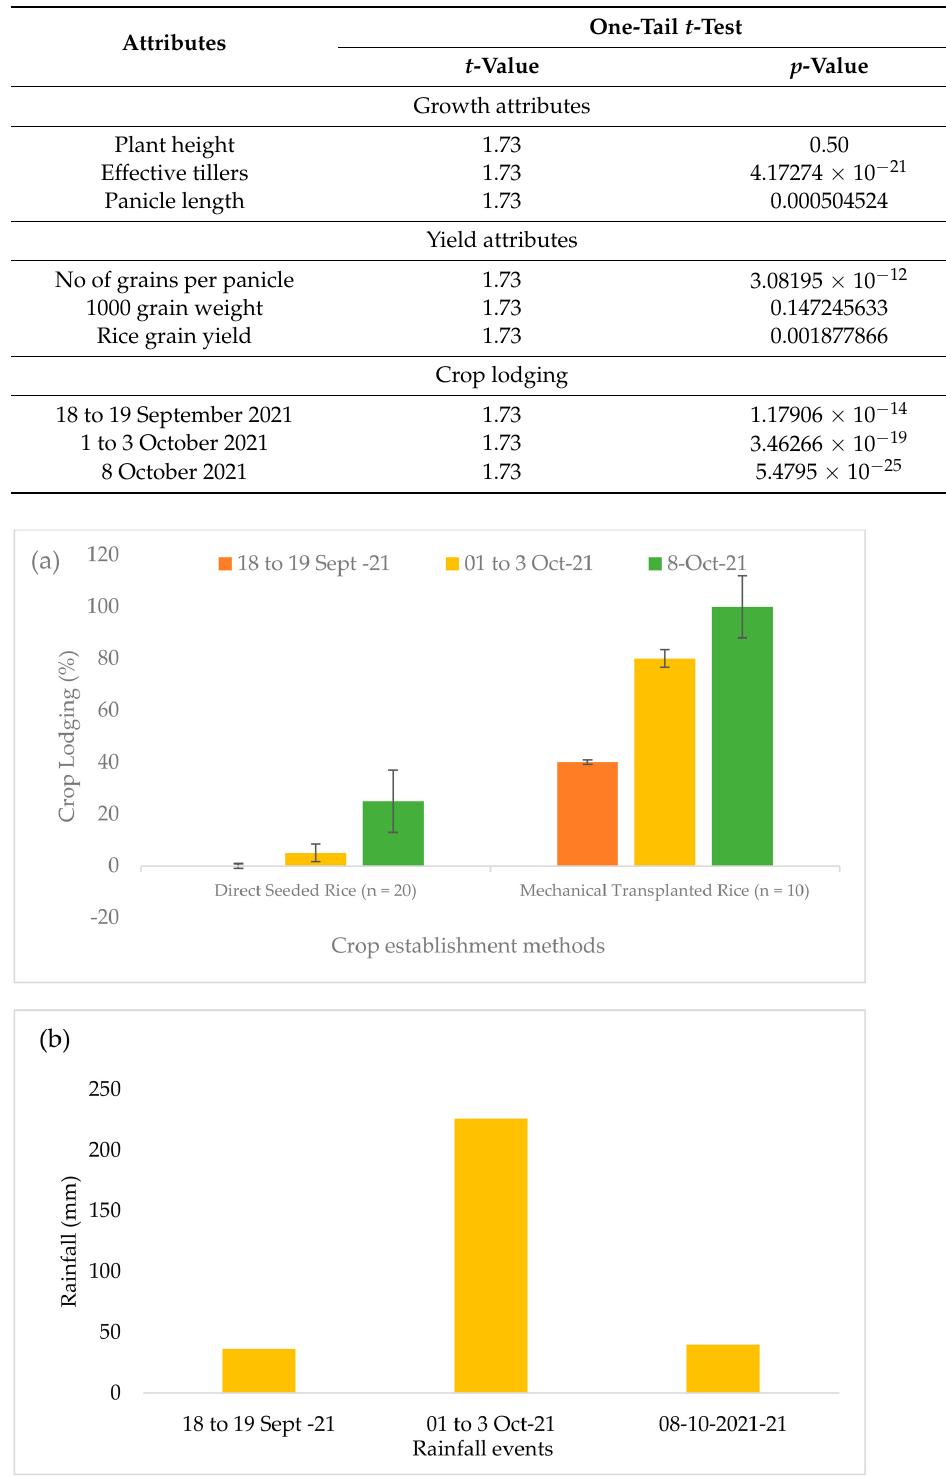
Table 1. One-tail t -test of different growth and yield attributes and crop lodging of direct seeding and mechanically transplanted rice establishment methods.